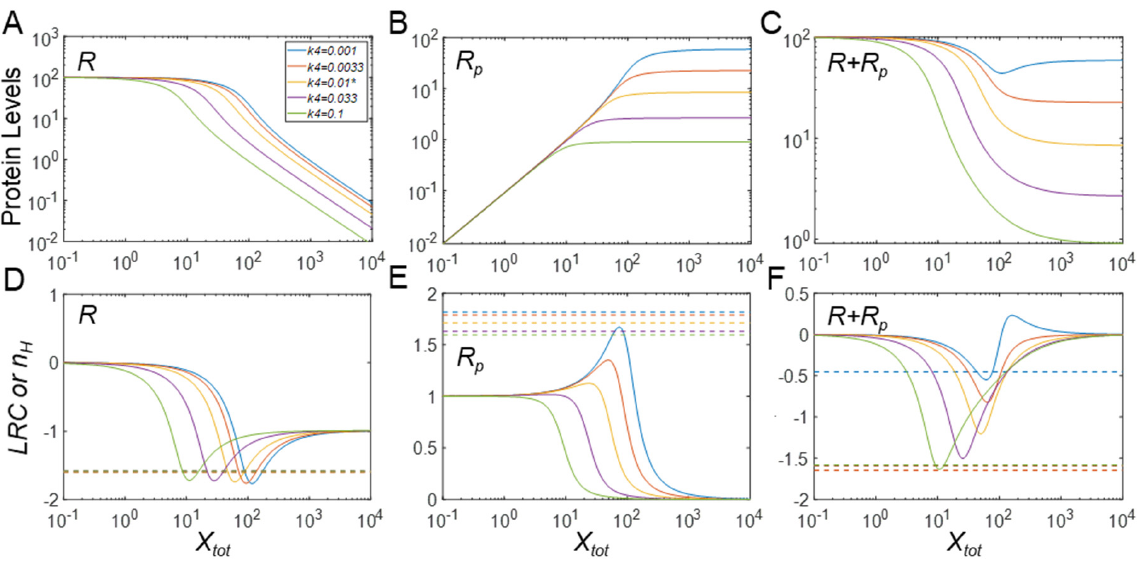
Figure 4. Effects of phosphorylation-induced changes in protein stability on ultrasensitivity in the full model when enzyme and basal substrate levels are comparable. ( A – C ) Steady-state DR curves for R vs. X tot , R p vs. X tot , and free R tot ( R + R p ) vs. X tot , respectively, for different values of k 4 , as indicated in panel ( A ). The same color scheme for k 4 values holds for all panels. ( D – F ) LRC (solid lines) and n H (dashed horizontal lines) pertain to R , R p , and free R tot , respectively. * k 4 = 0.01 is the default value. For these simulations, Y tot was set to 100.